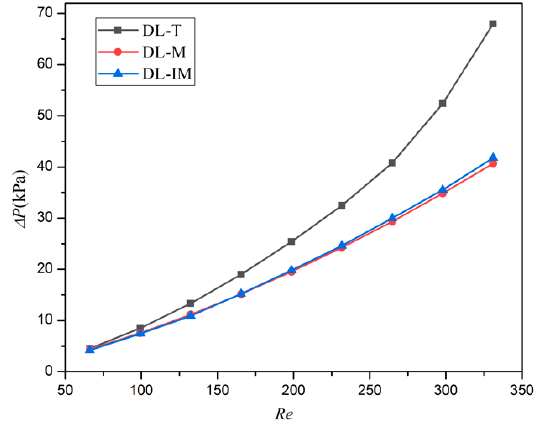
Figure 6. Pressure drop in DL-T, DL-M and DL-IM structure in different Reynolds number conditions.